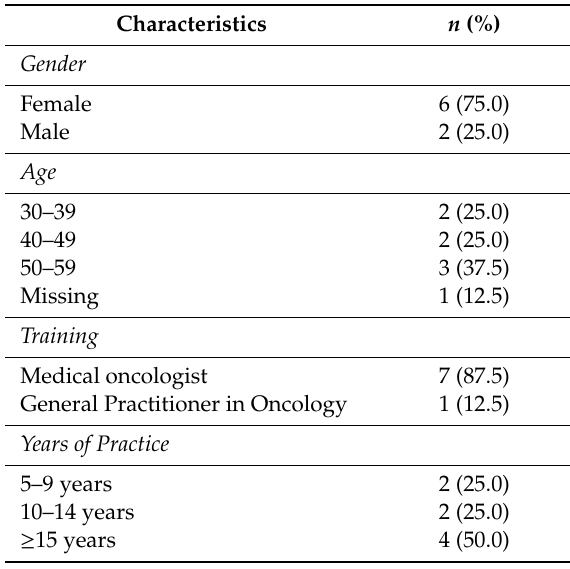
Table 2. Demographic and training characteristics of oncologists ( n =